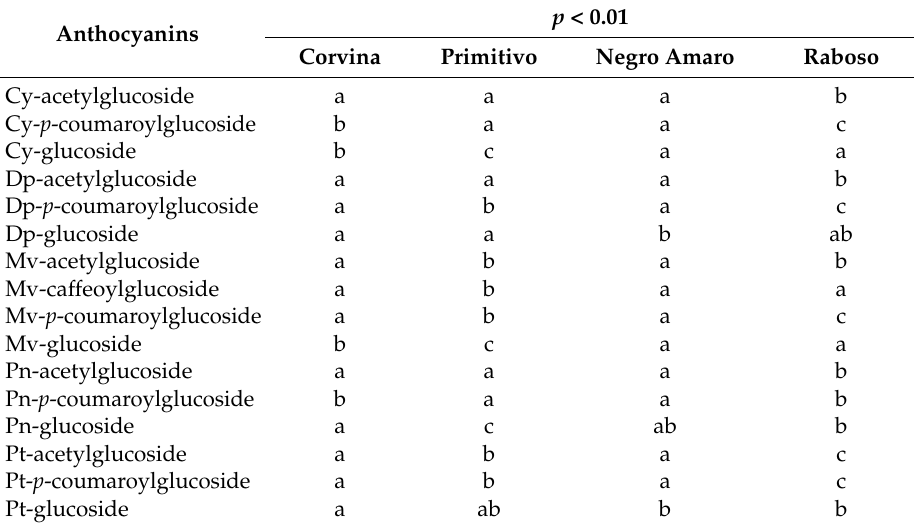
Figure 3. Biplot of the normalized UHPLC-Q/TOF anthocyanin signal intensities in the four grape varieties studied. P: Primitivo, C: Corvina, N: Negro Amaro, R: Raboso Piave. Dp, delphinidin; Cy, cyanidin; Pt, petunidin; Pn, peonidin; Mv, malvidin. glu, glucoside; p-coumglu, p -coumaroylglucoside; acetylglu, acetylglucoside. Table 2. Tukey’s test calculated using the normalized UHPLC-Q/TOF signal intensities of anthocyanins in the four grape varieties ( n = 4). The data with different letters are significantly different for p < 0.01. Cy, cyanidin; Dp, delphinidin; Mv, malvidin; Pn, peonidin; Pt, petunidin.